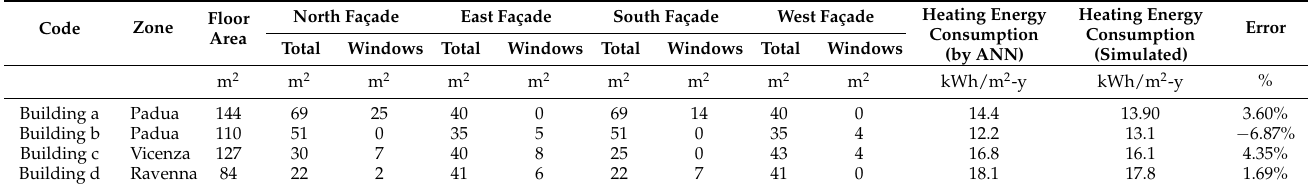
Table 11. Main geometrical characteristics and assessed heating energy consumption of four illustrative buildings. Code